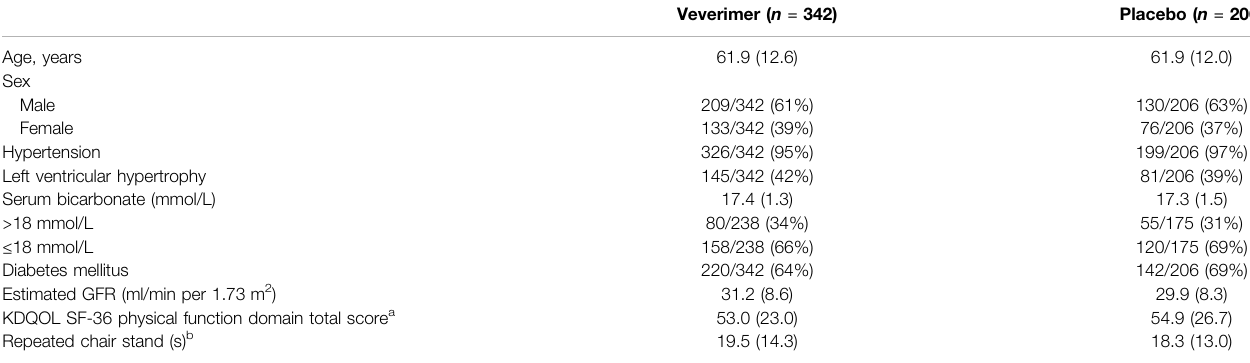
TABLE 2 | Baseline characteristics of patients in the meta-analysis